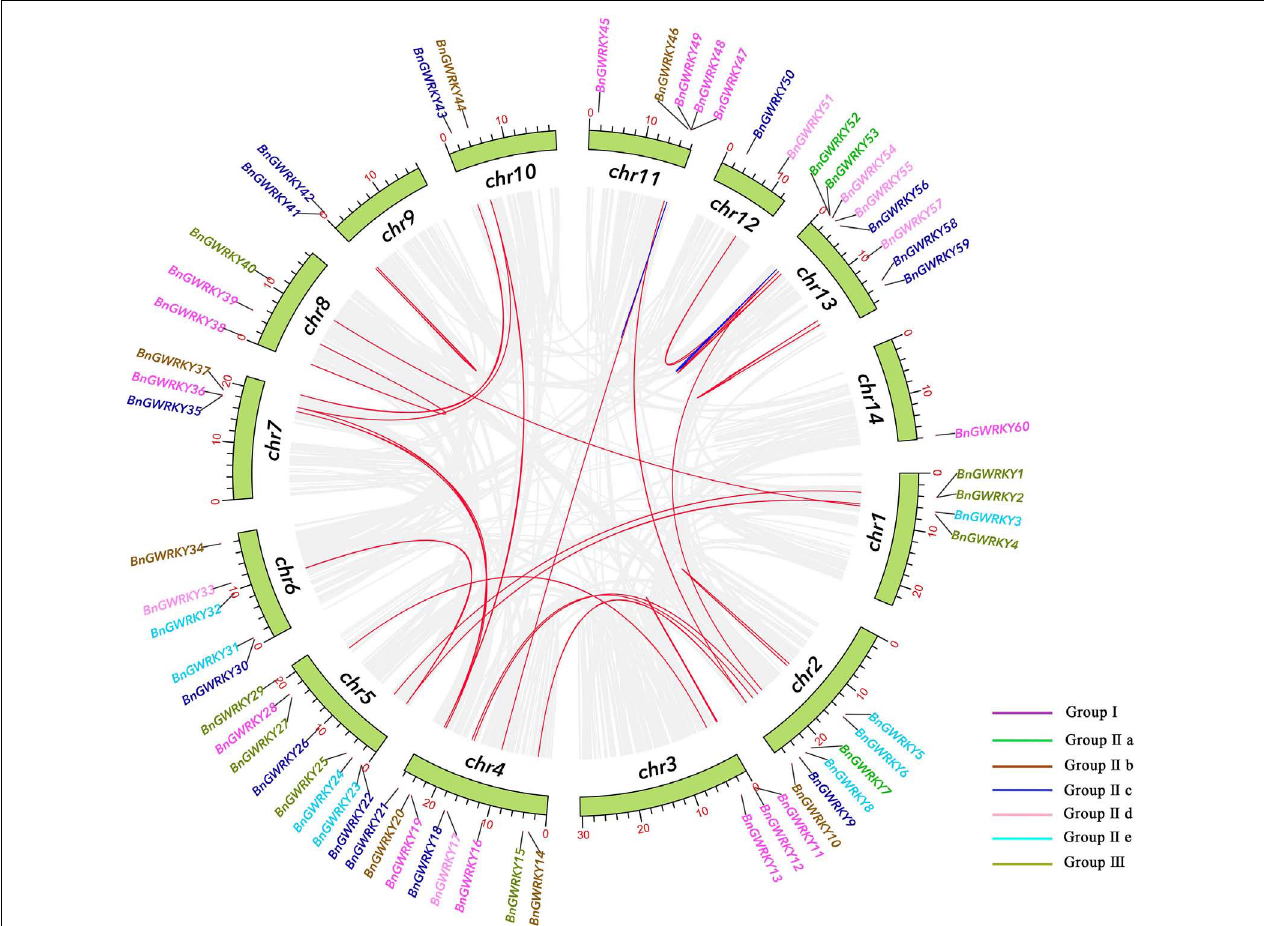
FIGURE 4 | Schematic representations for the chromosomal distribution and inter-chromosomal relationships of ramie WRKY genes. Gray lines indicate all synteny blocks in the ramie genome, duplicated WRKY gene pairs are connected with red lines, blue lines indicate tandemly duplicated gene pairs. As the legend shows, the color represents the grouping of